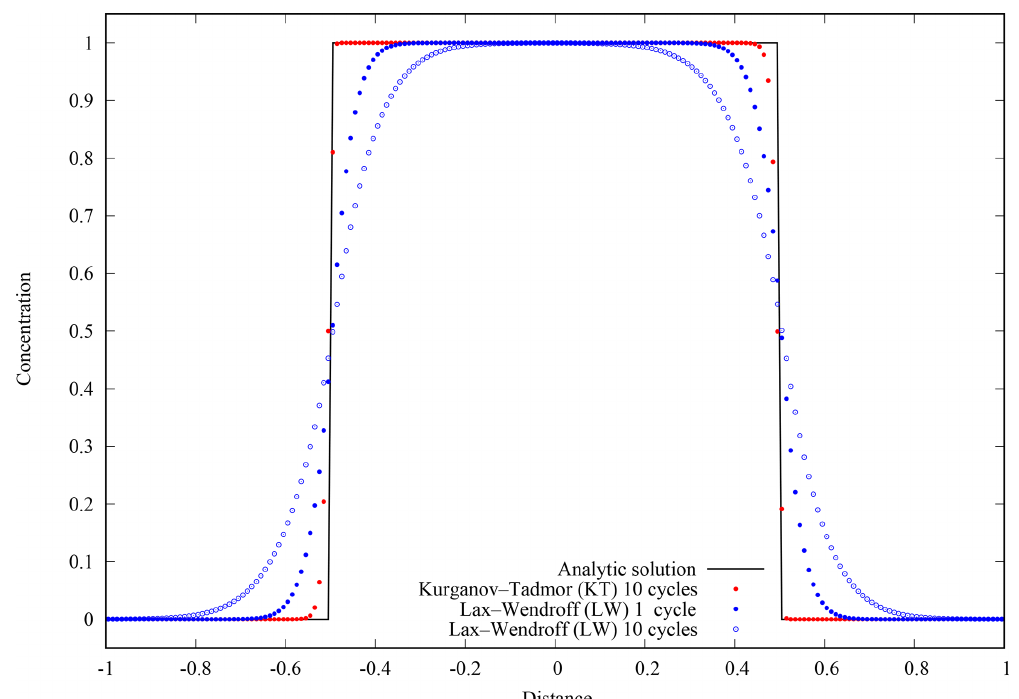
Figure 3. Benchmark 1 results. Step-like discontinuity given by Eq. (80) moving right at constant velocity u = 1 and without diffusion k = 0 on a domain x ∈ [− 1 , 1 ] with periodic boundary conditions. The solid black line shows the analytic solution after each periodic cycle, which coincides with the initial condition ( t = 0). Red dots show the KT + RK4 numerical solution after simulating 10 cycles (at t = 20). Blue dots and blue circles show the LW + EU1 results after 1 cycle ( t = 2) and 10 cycles ( t = 20), respectively. Note that mass (area below curves) is conserved in all the cases, but the KT + RK4 scheme adds almost no numerical diffusion and preserves discontinuities. Results use 200 equally spaced grid